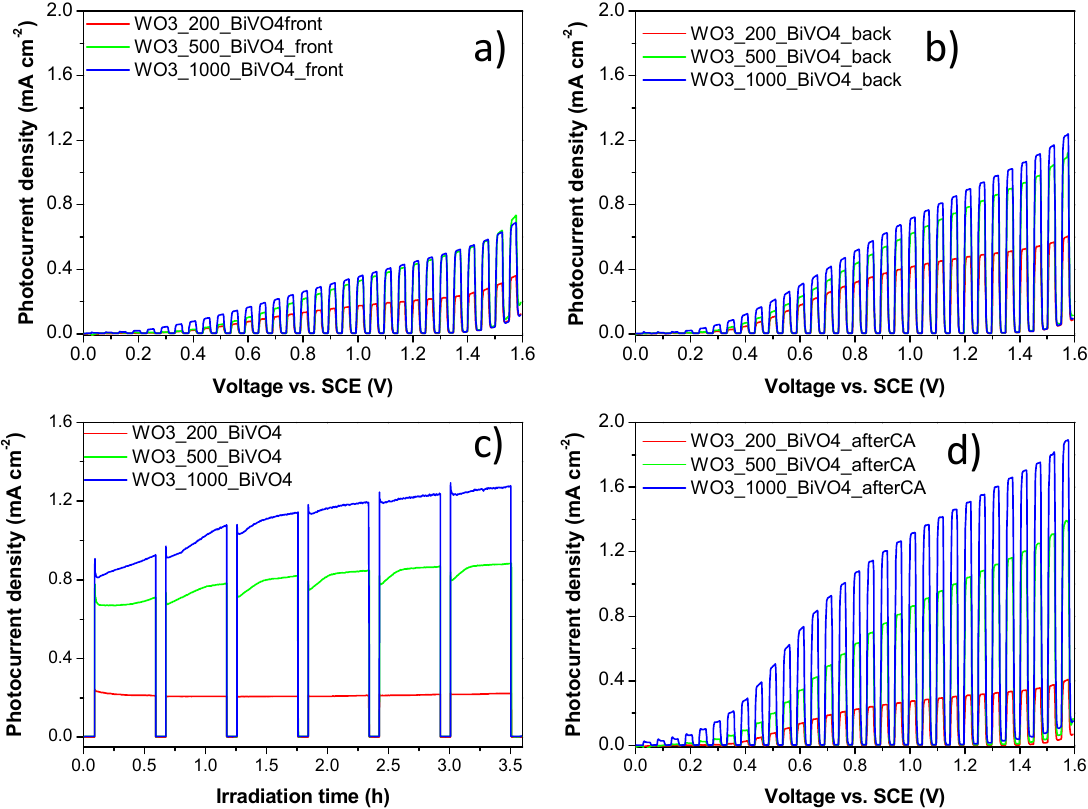
Figure 4. Effect of the WO 3 film thickness on the photoelectrochemical (PEC) performance of the WO 3 / BiVO 4 heterojunctions: Chopped Linear Sweep Voltammetry (LSV) curves under ( a ) front and ( b ) back irradiation of as-prepared samples; ( c ) chronoamperometry (CA) tests at 1.0 V vs. SCE; ( d ) chopped LSV curves under back irradiation recorded after CA tests (panel c ). All samples were post calcined at 400 °C for 2 h after BiVO 4 deposition. All measurements were made in a 0.5 M Na 2 SO 4 electrolyte solution under simulated AM 1.5 G solar irradiation.